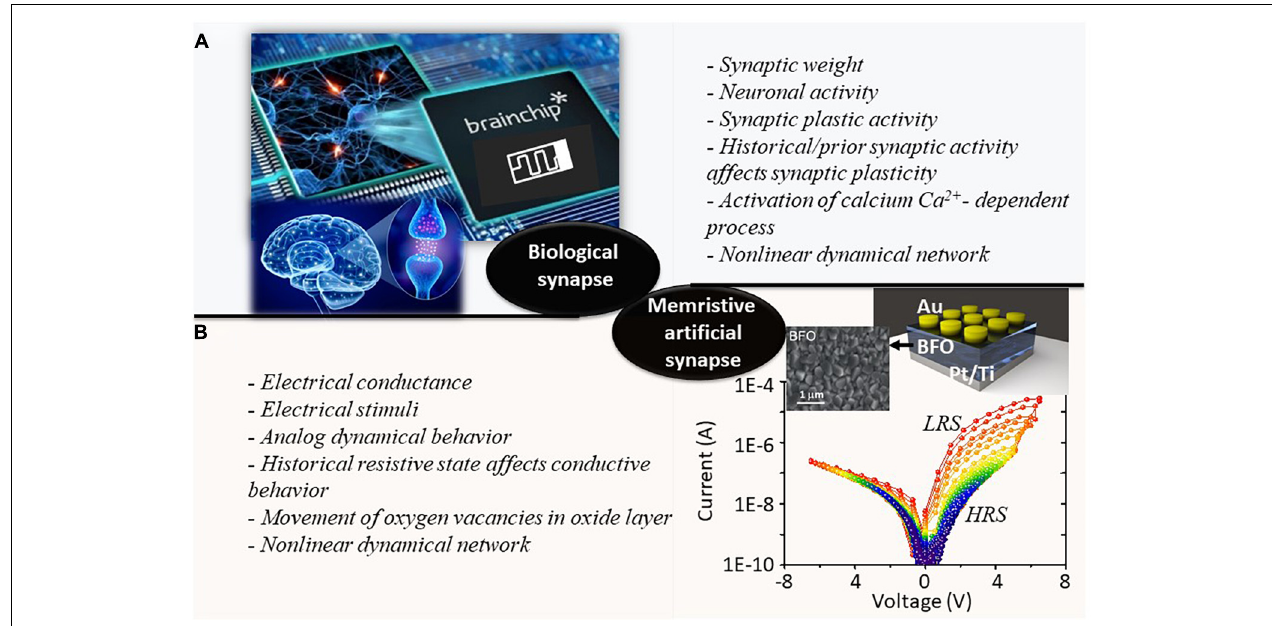
FIGURE 1 | Comparative schematic illustrations of panels (A) biological synapse and (B) BFO-based memristive artificial synapse. The key terms representing the nonlinear dynamical processes during the information transmission in the biological and artificial synapses are summarized and listed in each corresponding subfigure. The current–voltage ( I – V ) characteristics of BFO memristive devices under multiple linear sweeping biases of − V max → + V max → − V max are demonstrated in panel (B) with V max = 2, 2.3, 2.6 ... .6.2, 6.5 V. The colors of I – V curves are changing from blue color to red color with increasing biases. The topographic SEM image of the surface of BFO thin film is illustrated beside the schematics of BFO-based memristive device.